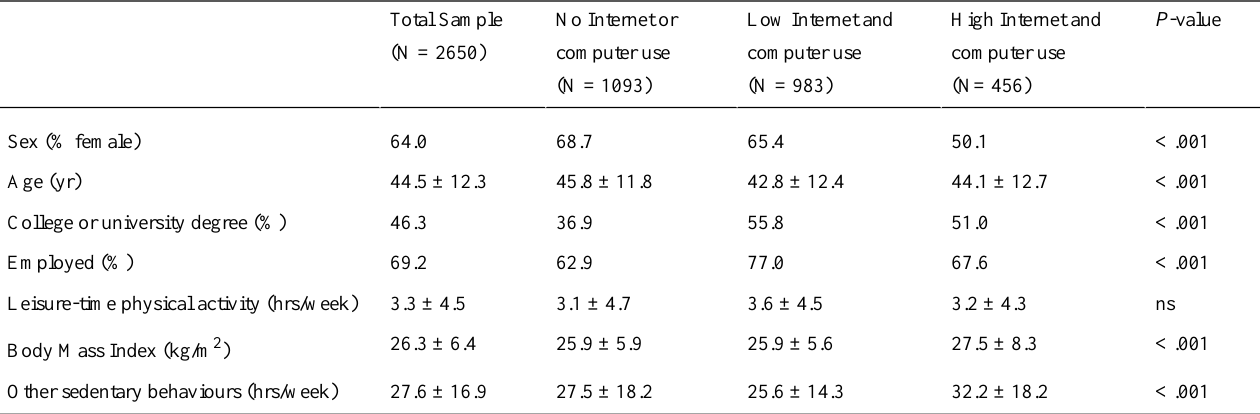
Table 1. Sample characteristics for total group and according to computer and Internet use categories (mean ± SD or %)